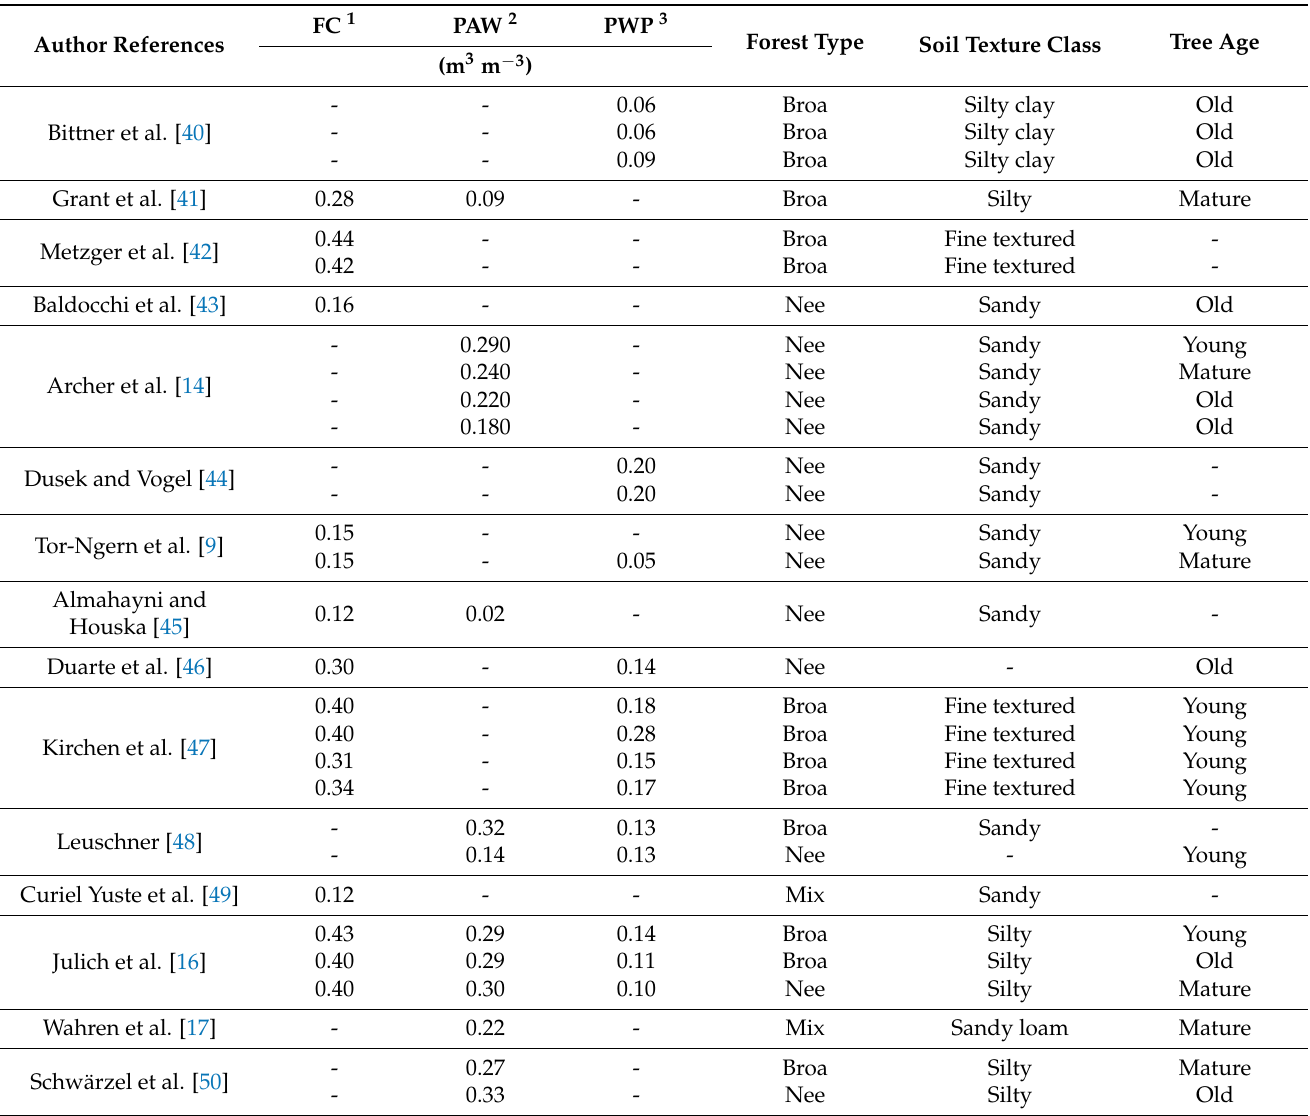
Table 2. Detailed information on soil water holding capacity from the reviewed literature. In the division Forest Type, the abbreviations Nee, Broa, and Mix stand for needle-leaved, broad-leaved, and mixed forest type,